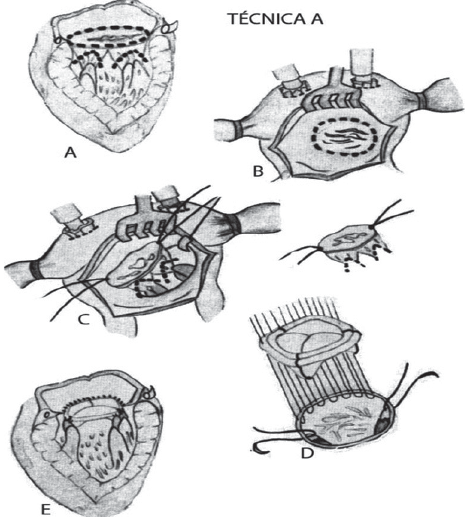
Fig. 1 - Prótese mitral com preservação dos elementos do sistema subvalvar: fixação do topo dos músculos papilares no anel posterior (Évora et al., Rev Bras Cir Cardiovasc. 1988;3(1):36-49)